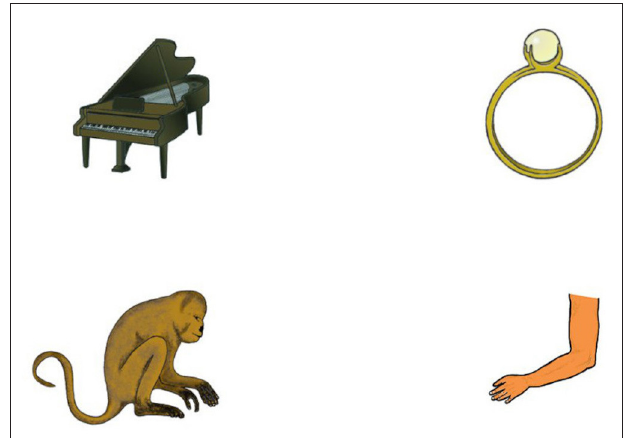
FIGURE 1 | An example of a same-gender condition display, including el brazo [masc.arm], el piano [masc.piano], el anillo [masc.ring], and el mono